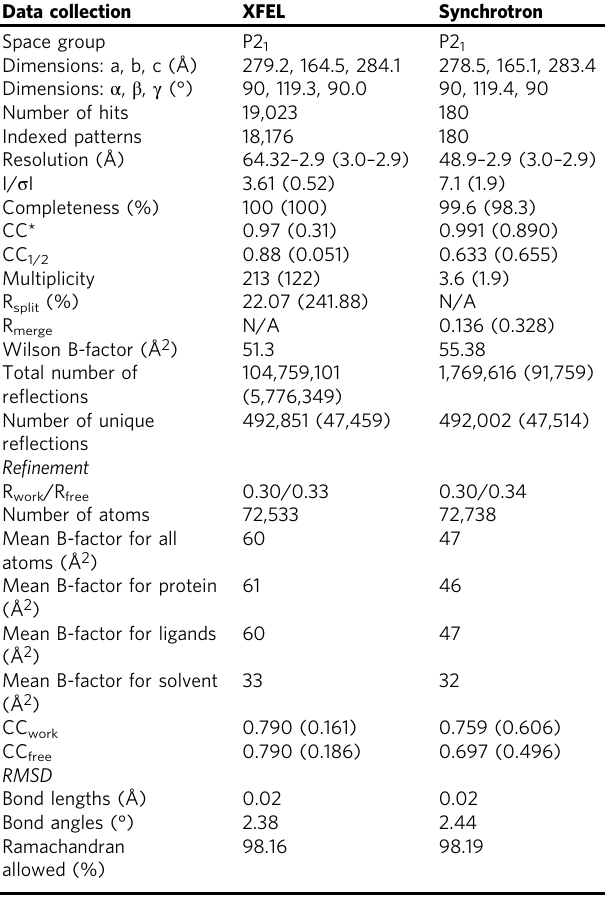
Table 2 Crystallography data and re fi nement statistics for the XFEL and synchrotron